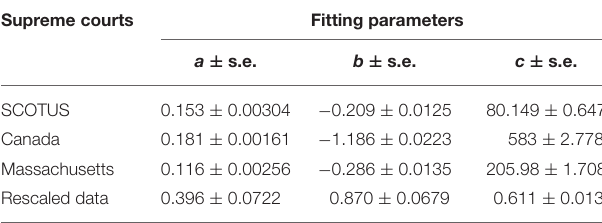
TABLE 2 | Fitting parameters for three Supreme court decision